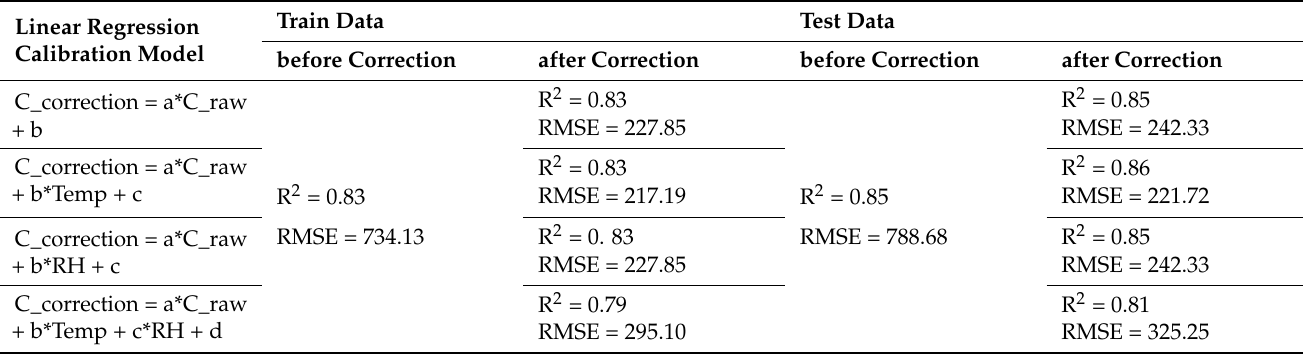
Table 3. Performances of the CO sensor with linear regressions (SLR and